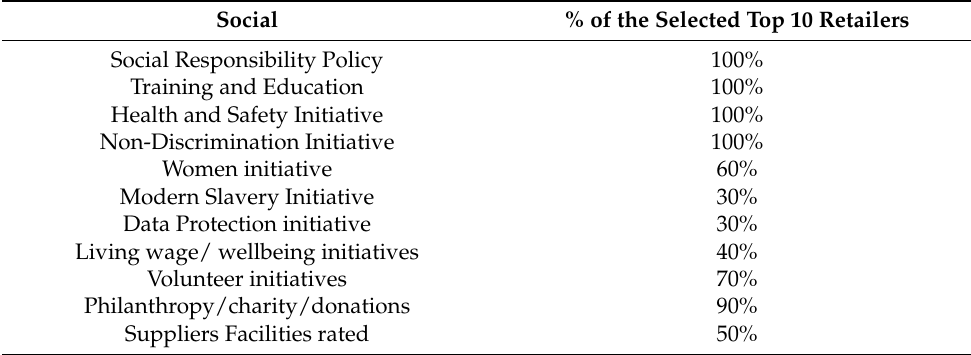
Table 5. Percentage of the top 10 retailers that communicate about a certain social item in their sustainability reports or related documentation available